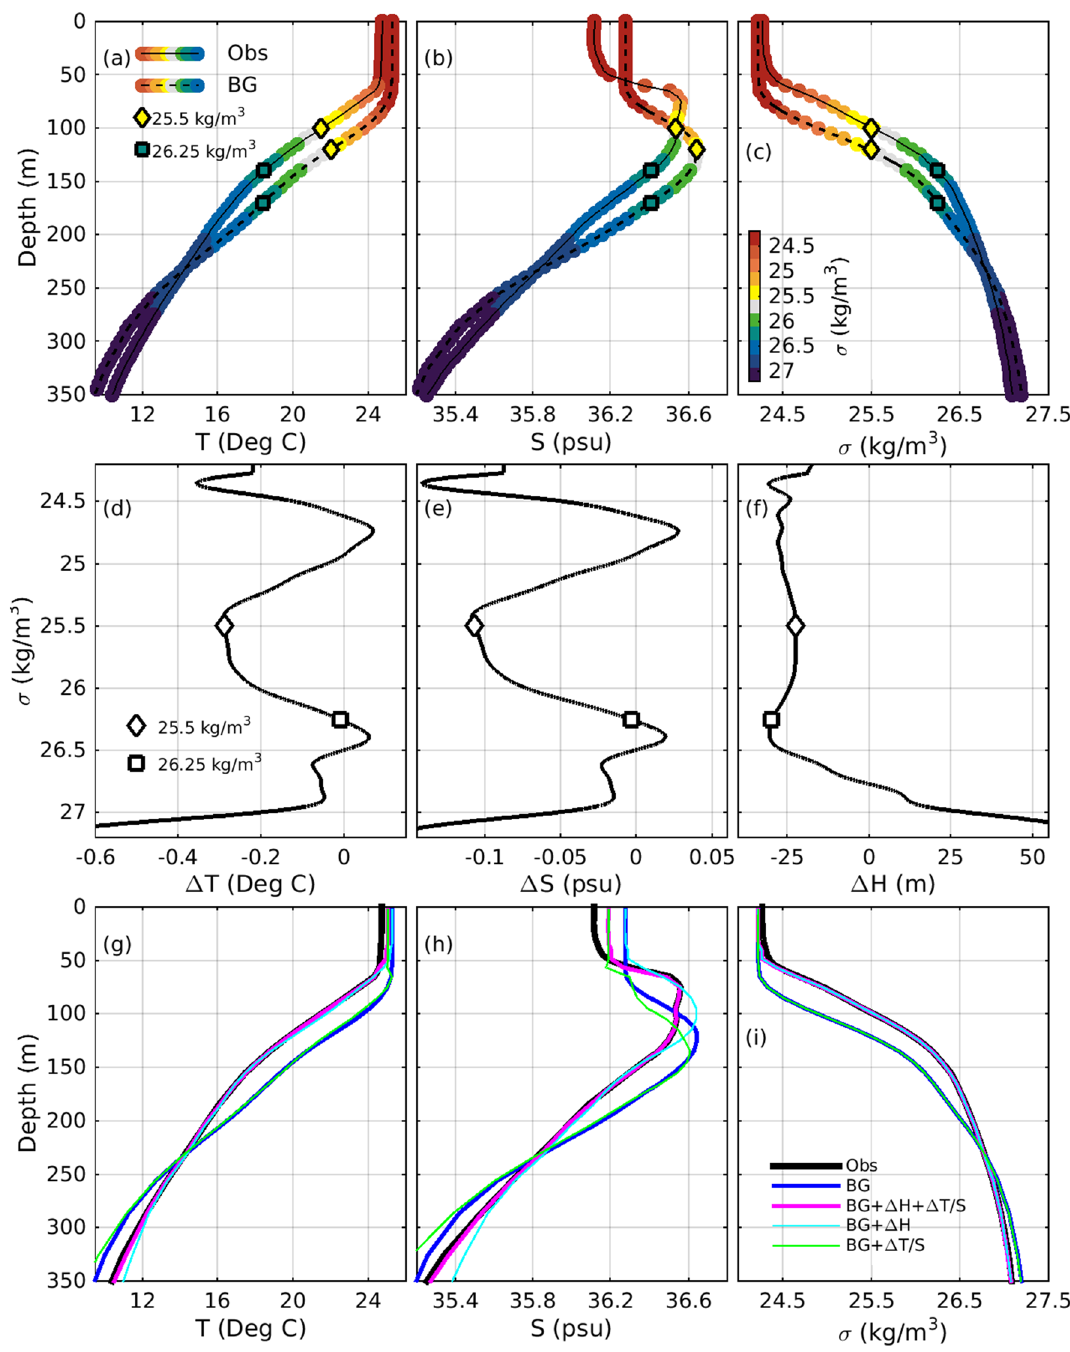
Figure 4. Profiles of ( a ) temperature, ( b ) salinity, and ( c ) density from observations and a background field; the difference between the observed and background, ( d ) temperature, ( e ) salinity, and ( f ) isopycnal depth; and profiles of ( g ) temperature, ( h ) salinity, and ( i ) density at each stage of feature mapping. In panels ( a–c ), profiles are plotted as a function of depth; and in panels ( d–f ), profiles are plotted as a function of potential density. In panels ( a–c ) the coloured dots along each profile denote the potential density. The colorbar for density is shown in panel ( c ). The diamonds (squares) in each panel highlight the value of each profile where the density is at 25.5 LUT (26.25) kg/m 3 . The profiles in ( d–f ) are examples of the values of the LUT used for feature mapping: ( d ) (cid:31) T , LUT LUT LUT ( e ) (cid:31) S , and ( f ) (cid:31) H , and the density vector for those panels are σ